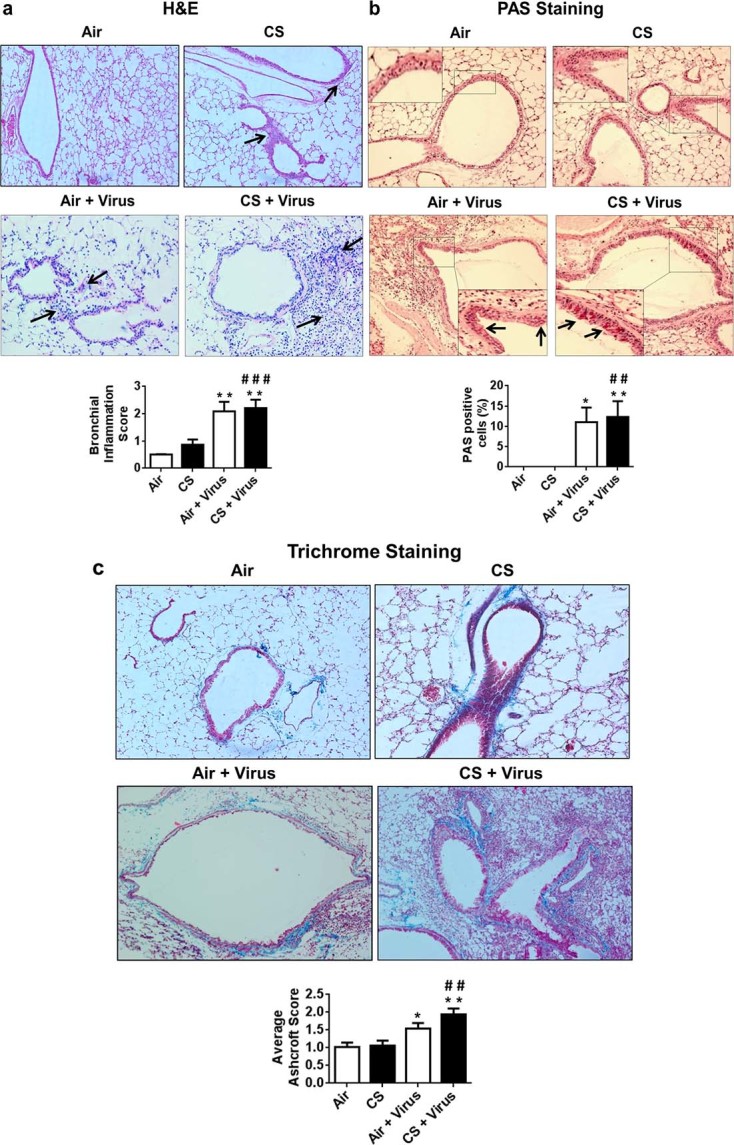
Chronic CS-exposed mice infected with IAV show persistent inflammation, mucus
hypersecretion, and pulmonary fibrosis.Data from chronic (6 months) air- or CS-exposed mice given intranasal
inoculation of either saline (control group) or influenza A virus (IAV;
treatment group) at ZT4-6 are shown. Lungs were harvested on day 9
post-infection. (a) Representative images of lung tissues stained
with hematoxylin and eosin (H&E) to demonstrate parenchymal and
bronchial airway inflammation. Bronchial inflammation scores were calculated
for each treatment group. (b) Representative images of lung tissues
stained with Periodic-acid Schiff (PAS) to visualize mucus overproduction
induced by IAV in the bronchial epithelium of chronic air- and CS-exposed
mice. Average mucus scores from 3–4 different areas per
slide/treatment group (n = 4-5mice/group) was used to calculate the
percentage of PAS positive cells. (c) Representative images of lung
tissues stained with Gomori’s Trichrome to visualize matrix
accumulation/collagen deposition and quantified by Ashcroft fibrosis score.
Original magnification x200. Data are representative of mean ±
SEM (n = 4-5 mice/group). * P < 0.05; ** P
< 0.01; significant compared to air- or CS-exposed mice. #
#
P < 0.01; # # #
P < 0.001; significant compared to air-exposed mice.